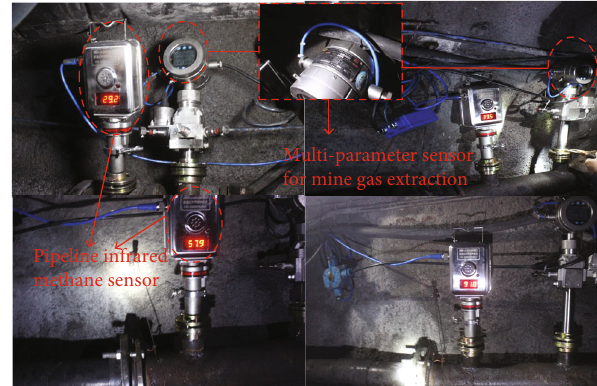
Figure 14: Gas fl ow concentration.